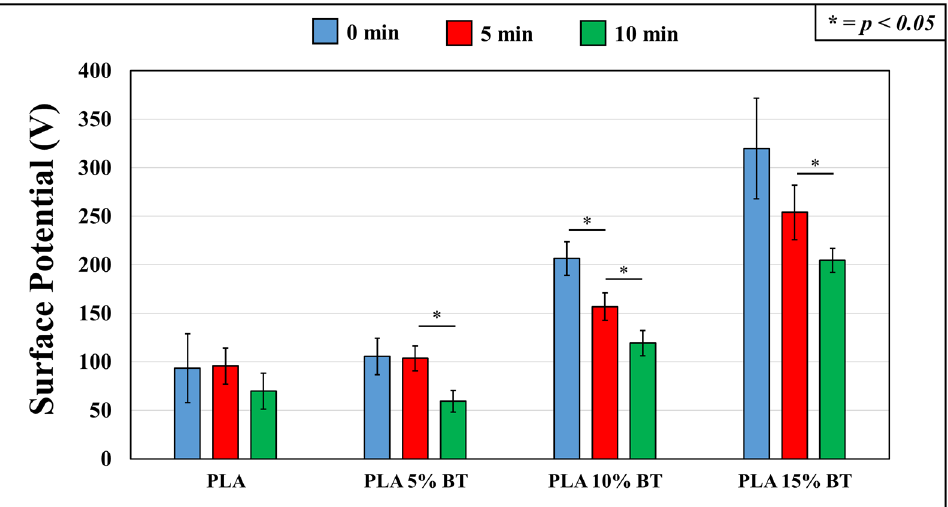
Figure 8. The surface potential of the substrates obtained before and after aging treatment. For each substrate, five samples have been used and maintained at a distance from the probe (2